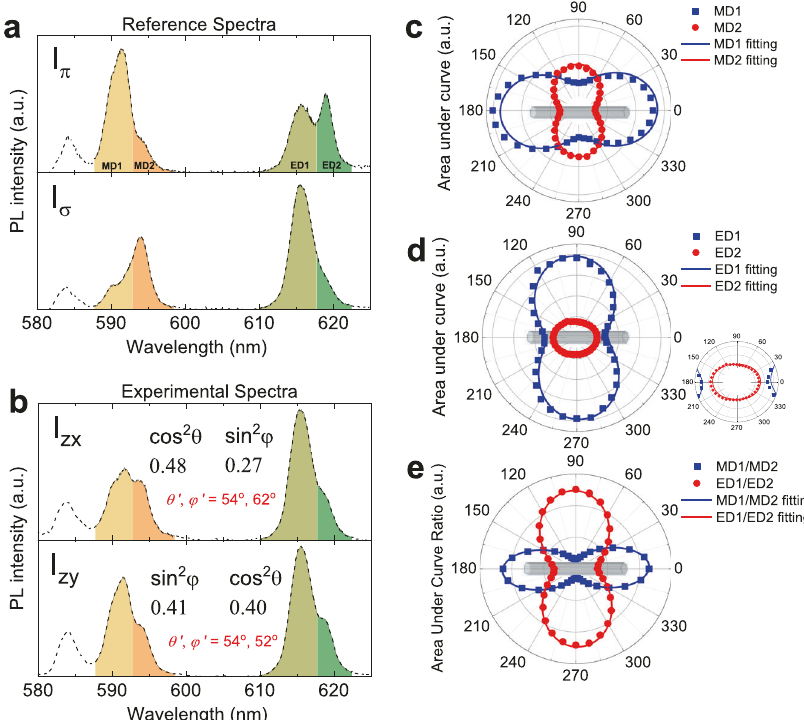
Fig. 4 Orientation analysis of a single NaYF 4 :Eu nanorod by area under curve ratiometry (AUCR). a Reference emission spectra of the photoluminescence (PL) of a NaYF 4 :Eu nanorod polarized parallel (I π ) and perpendicular (I σ ) to the rod axis and ( b ) experimental spectra (I zx , I zy ) of the nanorod with an orientation θ ′ , φ ′ (also shown in Fig. 3d, e). The selected wavelength ranges (MD1, MD2, ED1, and ED2) used for AUCR are highlighted in different colors, from which the values of the trigonometric functions of ( θ , φ ) and the absolute values of ( θ ′ , φ ′ ) were calculated using Eqs. 8 – 13. The results of the same AUCR analysis for a large number of particles are shown in the Supplementary Data 1. c – e Polar diagrams and fi tting curves of the selected areas under curve for ( c ) MD1 and MD2, ( d ) ED1 and ED2, and ( e ) their ratios MD1/MD2 and